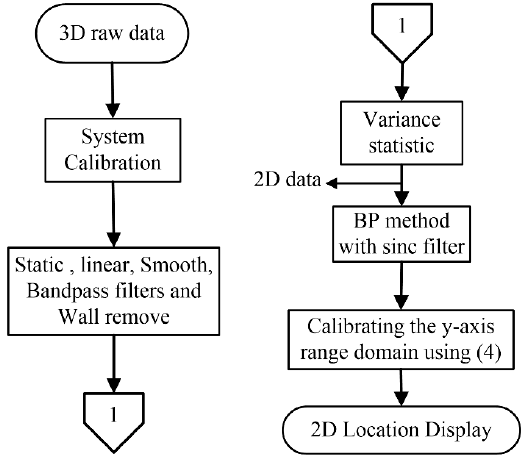
Figure 6. Flowchart of the proposed method.